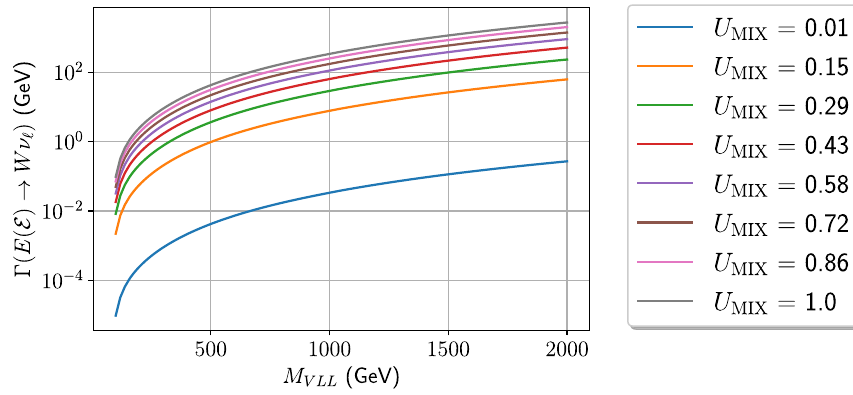
Fig. 1 Decay width as a function of the VLL’s mass, both displayed in GeV. Each coloured line is representative of a different mixing element, whose numerical value is displayed in the box to the right of the